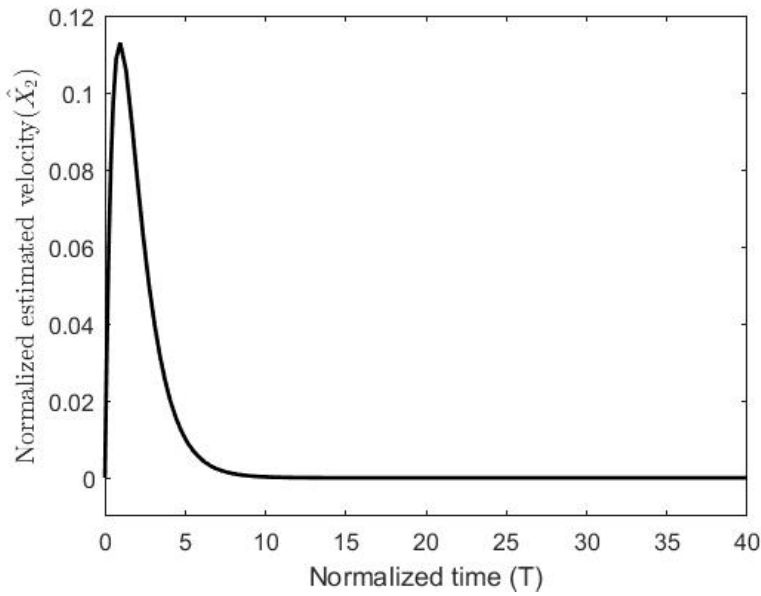
Figure 6. The normalized estimated velocity with the coupling constant at a gap distance of 0.3.